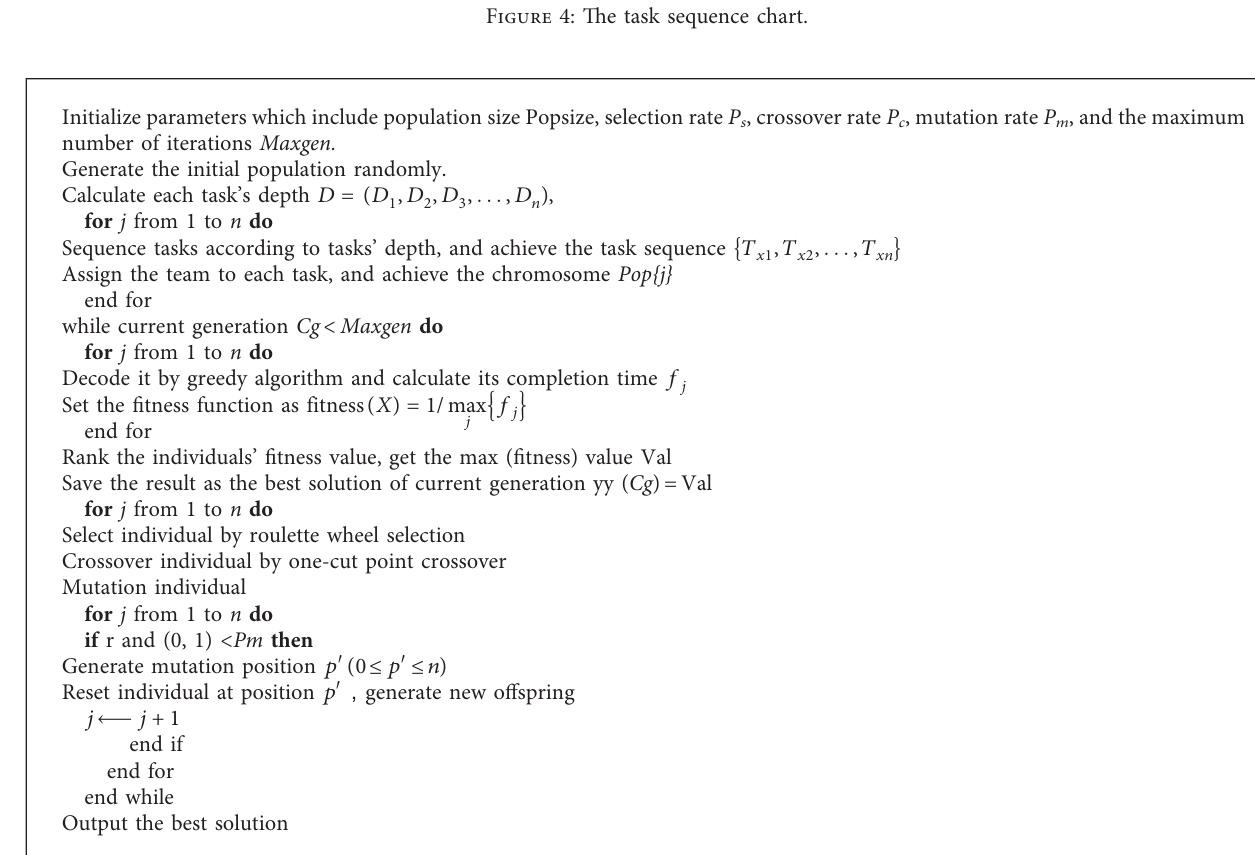
Figure 4: The task sequence chart.